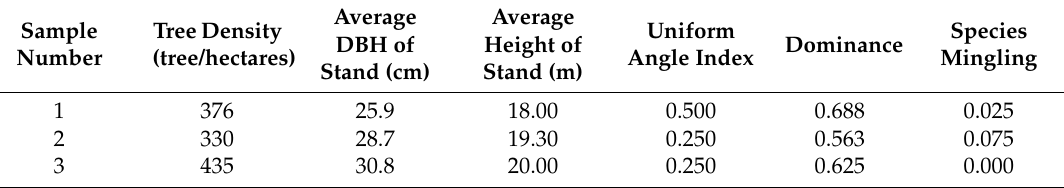
Table 4. Calculation results of other stand factors based on image point cloud data.